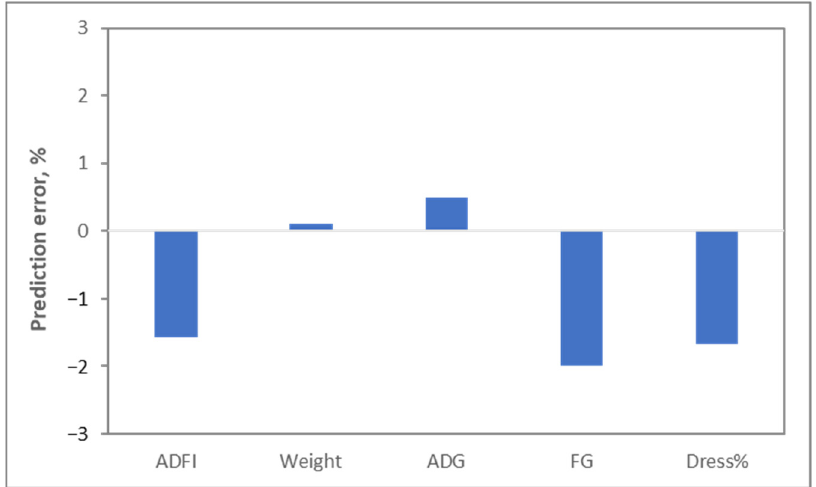
Figure 2. Prediction error between modeled estimates of pig food intake (ADFI: average daily food intake), gain (ADG: average daily gain), weight, efficiency of conversion of food into weight gain (FG: ADFI/ADG ratio) and dressing percentage (Dress%: yield of carcass as percentage of body weight). Ferguson, personal communication.